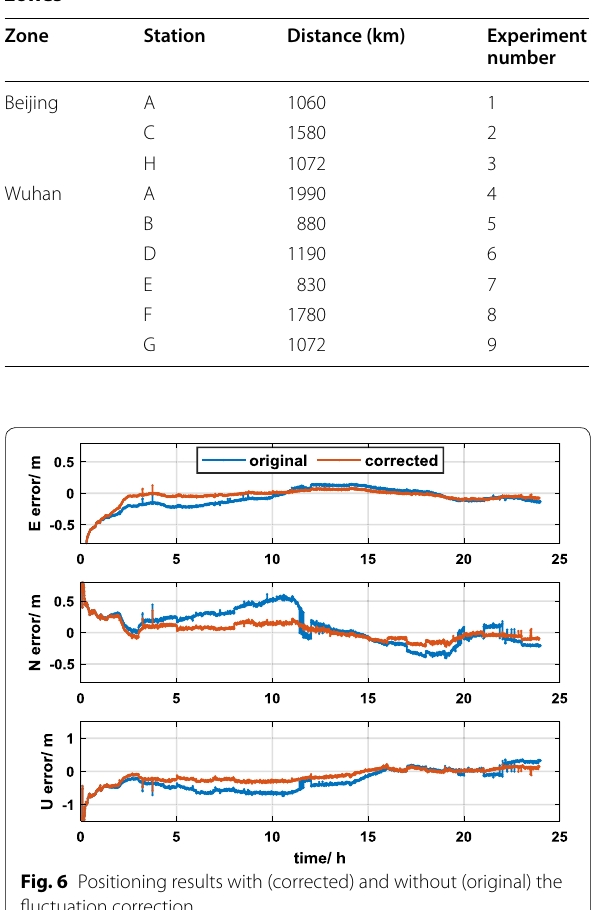
Table 1 Stations used for verification and corresponding zones